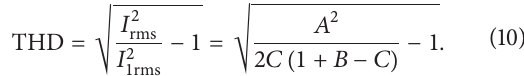
The RMS values of the fundamental-frequency current and the full-frequency current are basically the same when 𝛽 = 0